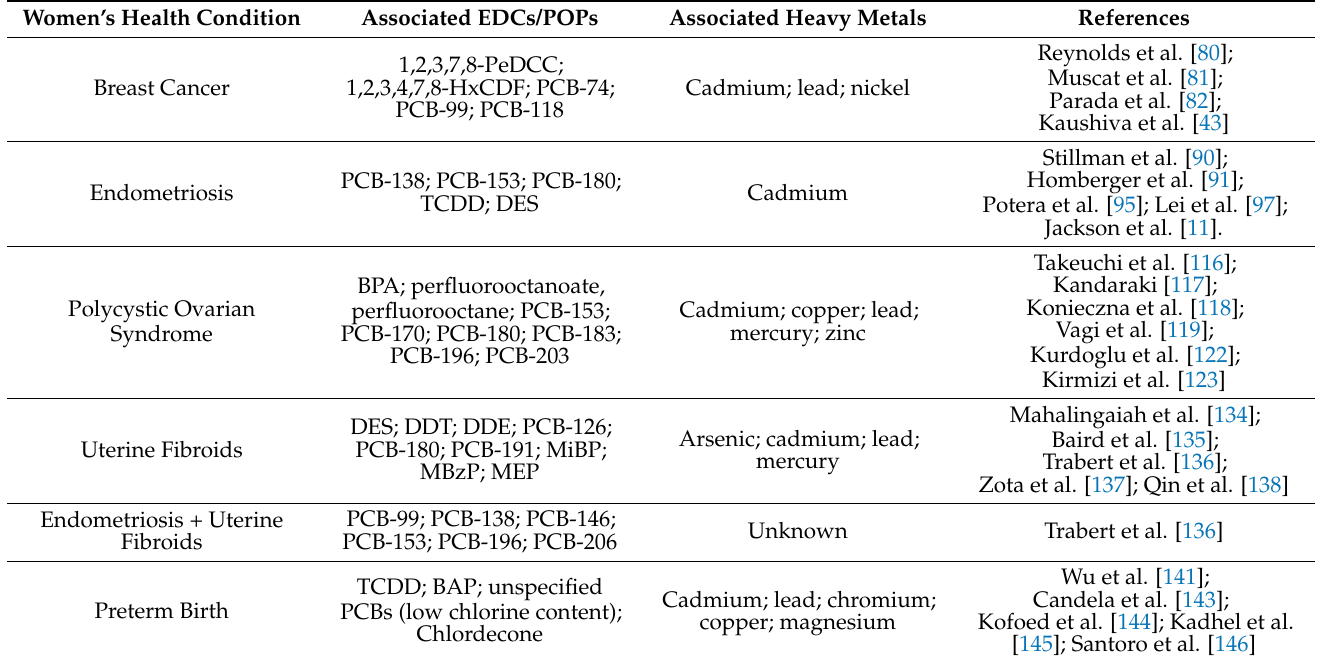
Table 1. List of POPs, EDCs, and heavy metals associated with breast cancer, endometriosis, polycystic ovarian syndrome, uterine fibroids, and preterm